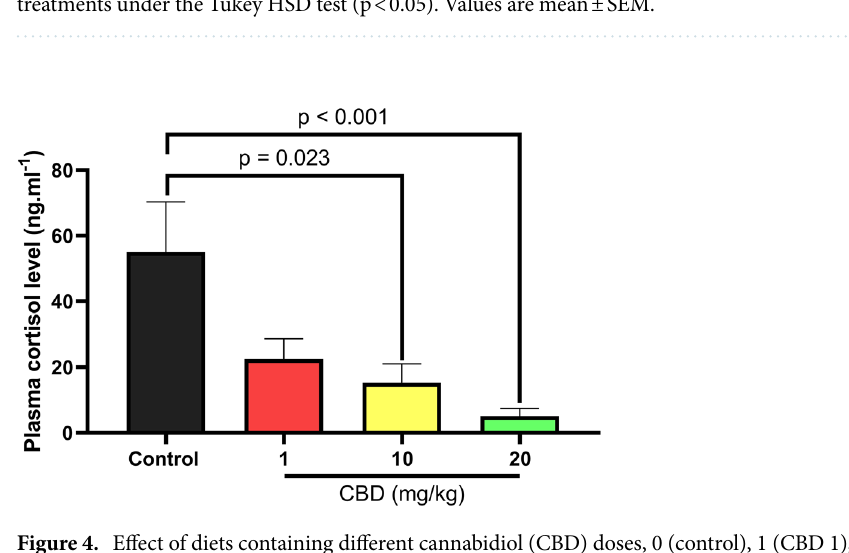
Figure 4. Effect of diets containing different cannabidiol (CBD) doses, 0 (control), 1 (CBD 1), 10 (CBD 10) and 20 mg/kg (CBD 20) on the baseline plasma cortisol levels of Nile tilapias (n = 8). Fish received the treated diets for 28 days before the baseline measure was collected. Highlighted p-values indicate a significant difference between treatments under the Tukey HSD test (p < 0.05). Values are mean ±